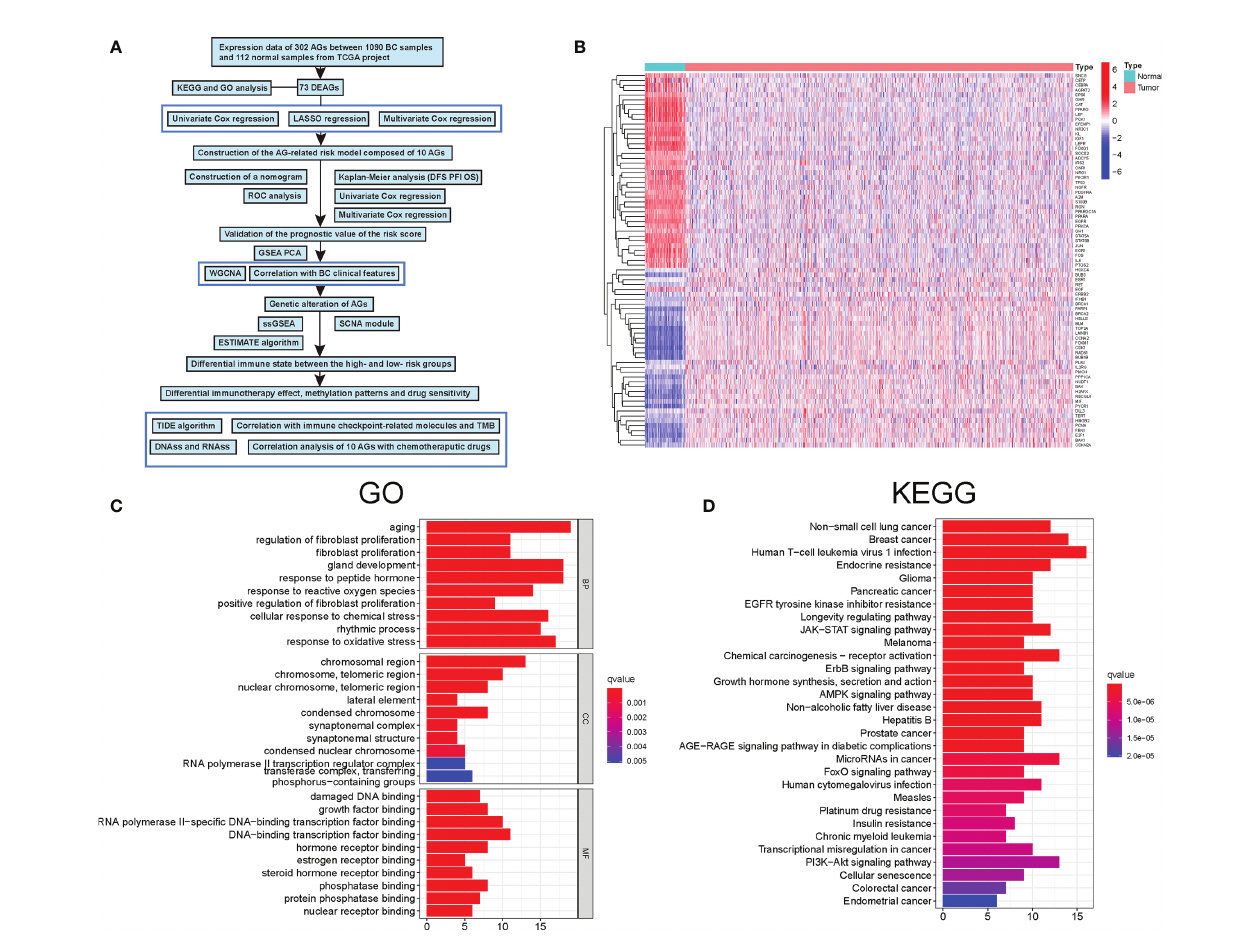
FIGURE 1 | Characteristics and differences of aging-related genes (AGs) in breast cancer (BC). (A) Flowchart indicating the analysis procedure. (B) The expression of 73 differentially expressed aging-related genes (DEAGs) in BC tissues and normal tissues. (C) Gene Ontology (GO) enrichment analysis of 73 DEAGs. (D) Kyoto Encyclopedia of Genes and Genomes (KEGG) enrichment analysis of 73